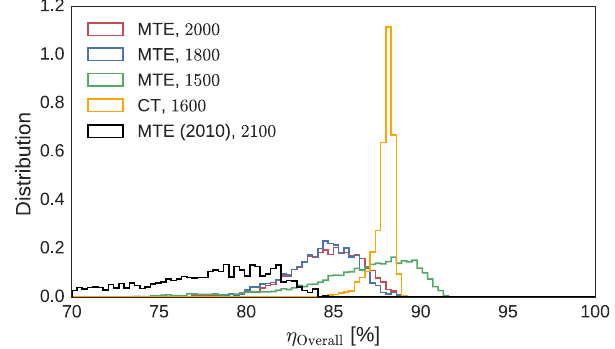
FIG. 16. Histogram showing the distribution of η typical intensity values are in units of 10 10 ppp at extraction from the PS.